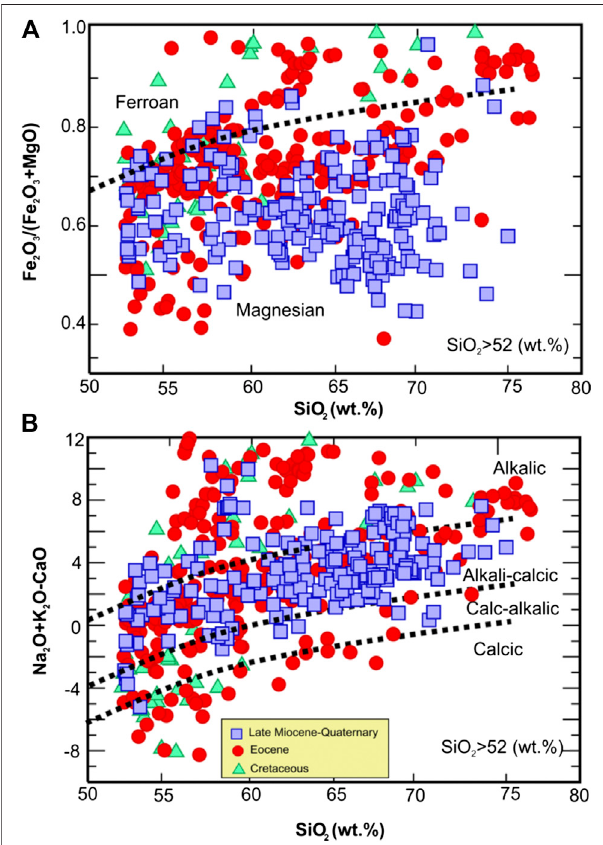
FIGURE8| PlottingoftheintermediatetoacidicrocksintheFeO/(FeO+ MgO) vs.SiO 2 (A) and Na 2 O+K 2 O-CaOvs. SiO 2 (Frostetal.,2001)diagrams (B) ,whichareusedforintermediateandacidicrockclassi fi cation.Seethetext for more information.